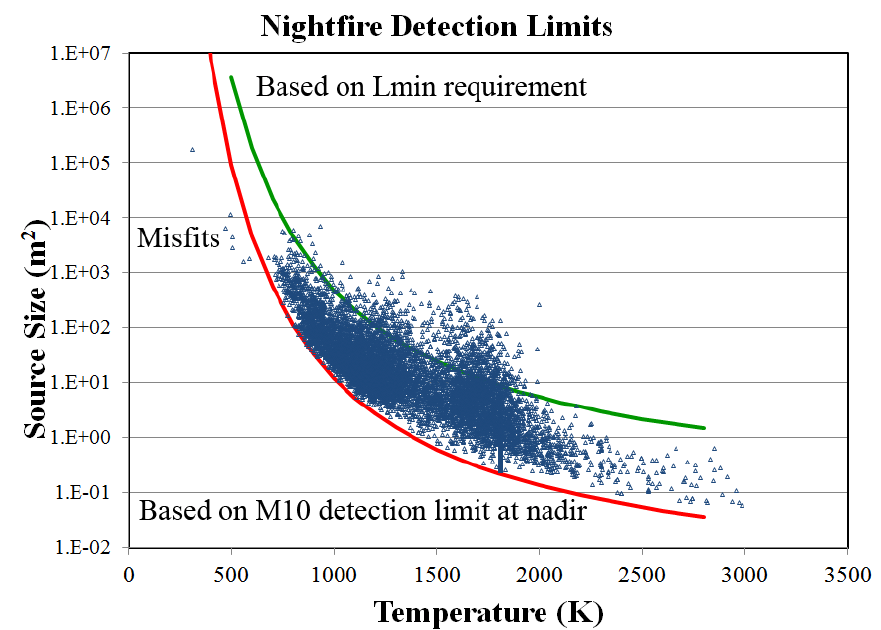
Figure 8. Plot of Nightfire temperature vs. source area estimates. The red line indicates the theoretical detection limit modeled based on the M10 detection limit. The green line is the hypothetical detection limit based on the published M10 minimum detectable radiance (Lmin) requirement [12].